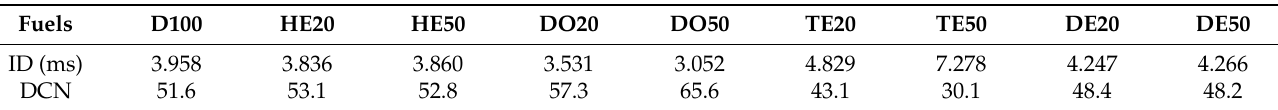
Table 3. The measured DCN of test fuels.